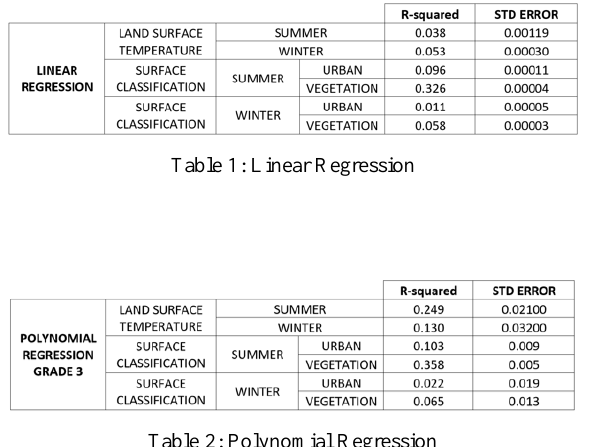
Table 2: Polynomial Regression